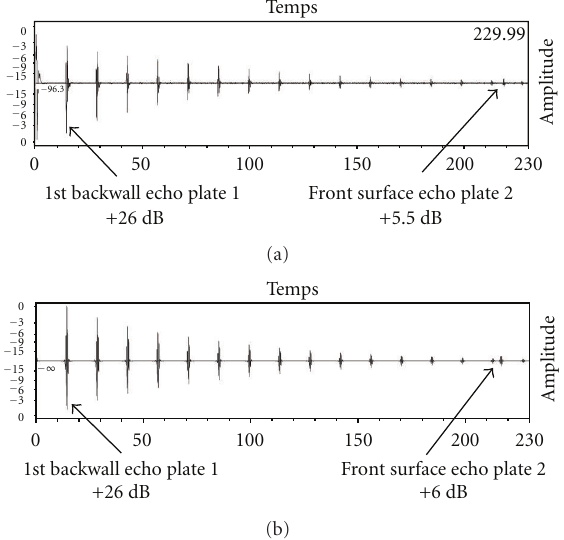
Figure 5: Inspection through screens for a normal incidence con- figuration at 2.25 MHz, experimental (a) and simulation